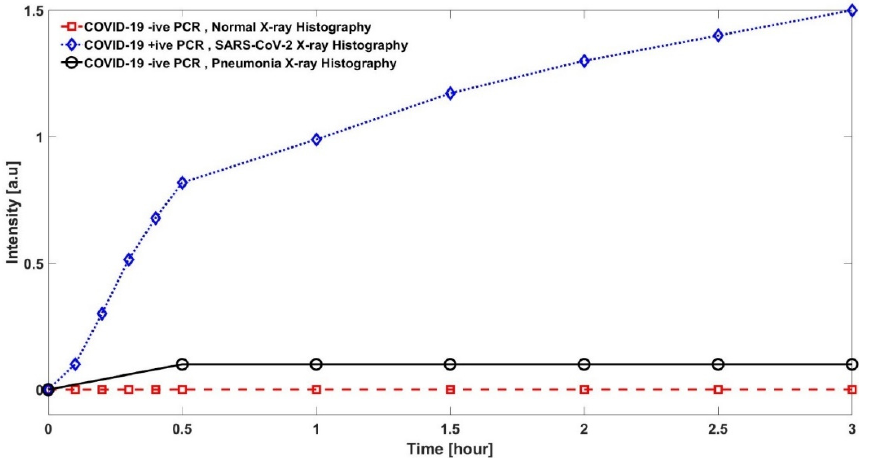
Figure 10. Comparison of Normal, COVID-19 and Pneumonia patients in terms of intensity with diameters 200 µm POF are